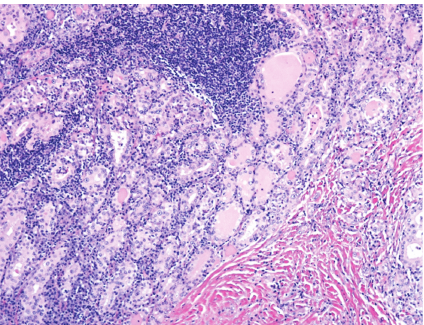
Figure 12: Hashimoto thyroiditis: there is extensive lymphocytic infiltrate with germinal center formation. Follicular cells are slightly enlarged with partial nuclear clearing (hematoxylin-eosin, original magnification × 100).